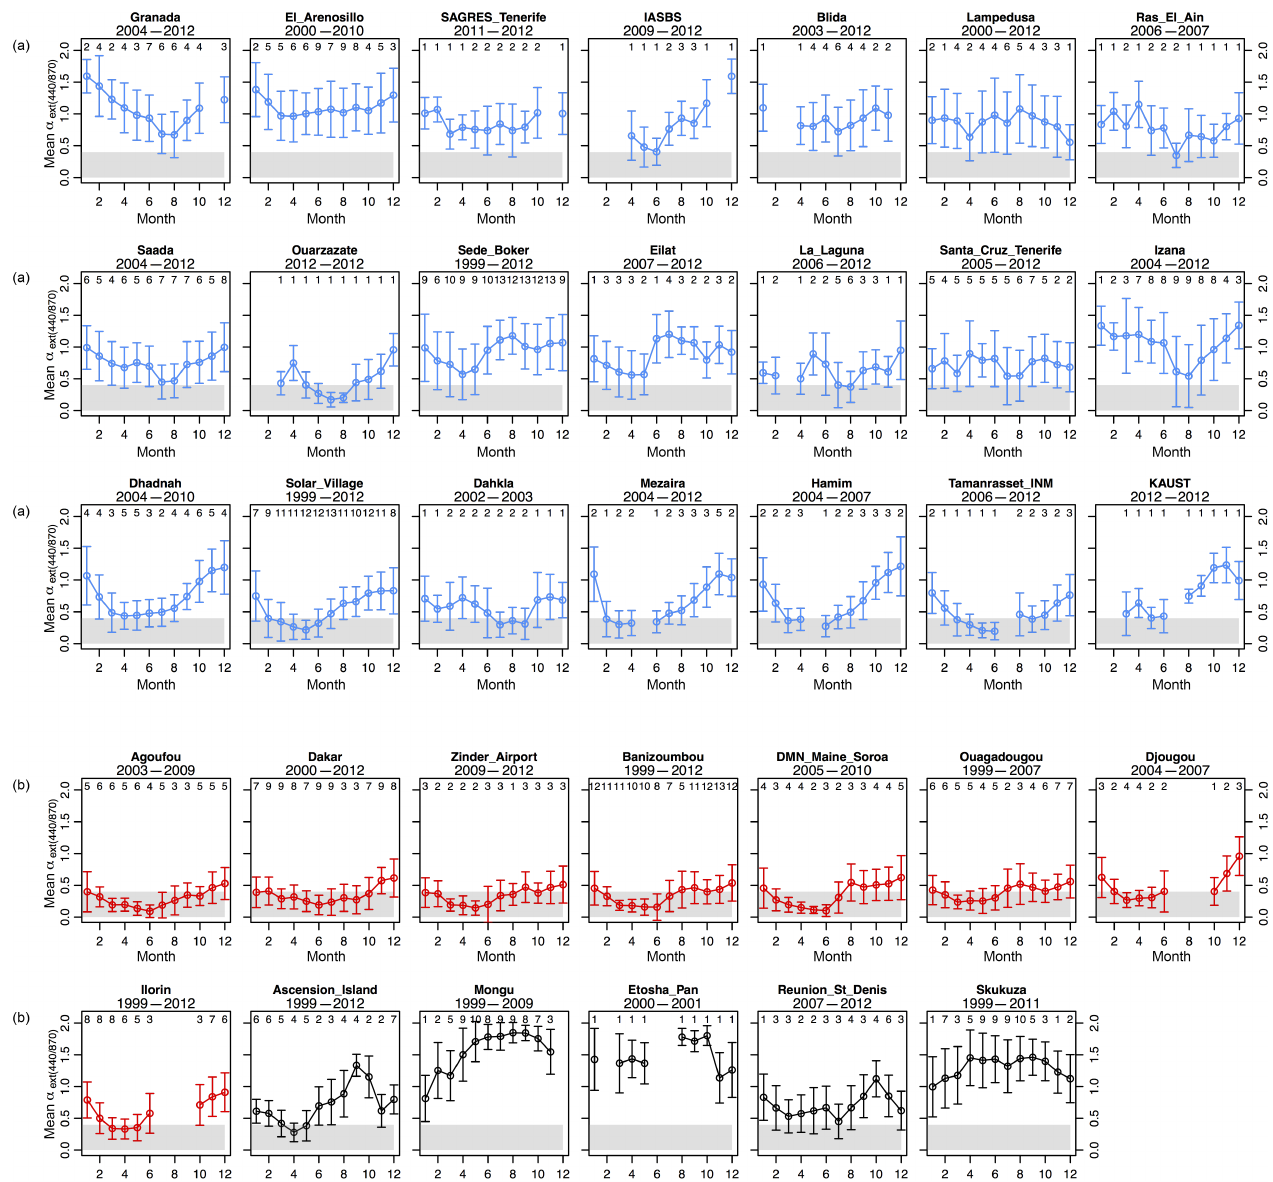
Figure 4. (a) Same as Fig. 3a but for observed α ext ( 440 / 870 ) from AERONET. Gray shaded region represents α ext ( 440 / 870 ) values typical of aerosols dominated by coarse particles (Holben et al., 2001; Ogunjobi et al., 2008). Whiskers are ± 1 standard deviation across daily means within a given month. (b) Same as Fig. 3b but for observed α ext ( 440 / 870 ) from AERONET.